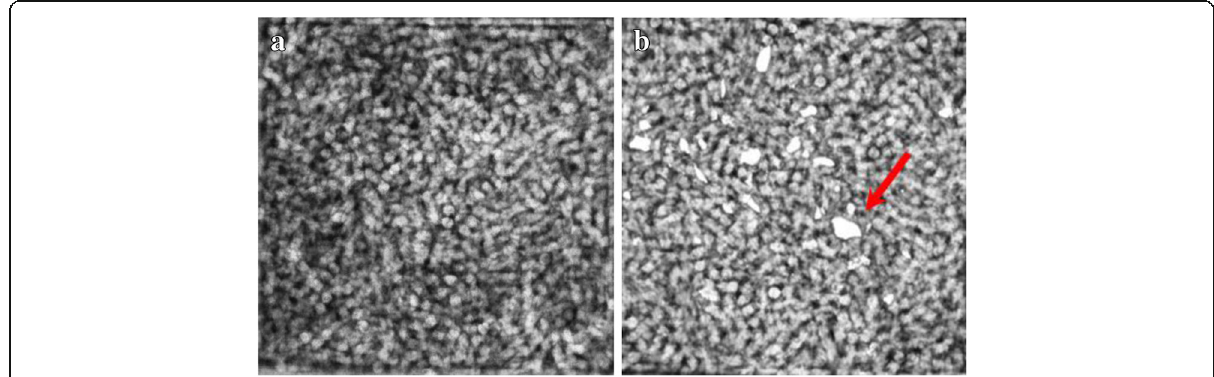
Fig. 6 Digital X-ray radiography images of samples of GAC-virgin a and GAC-Top “ exhausted ” b before and after use in a rum production process. Energy: 22 keV – 125 mAs, sample thickness ( x ): 12 mm